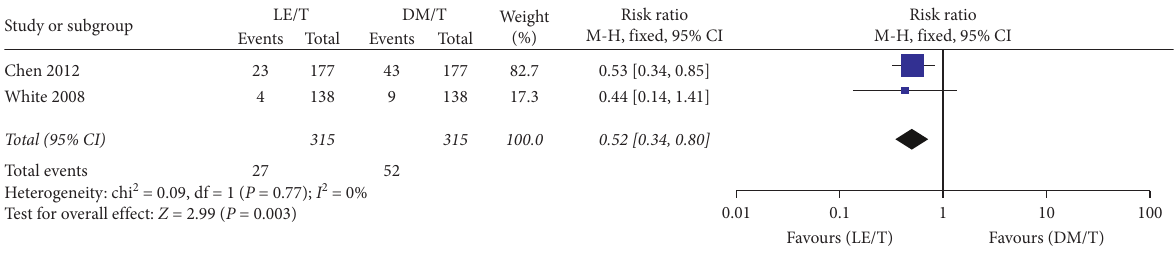
Figure 9: Incidence of overall adverse events in the groups treated with LE/T or DM/T.